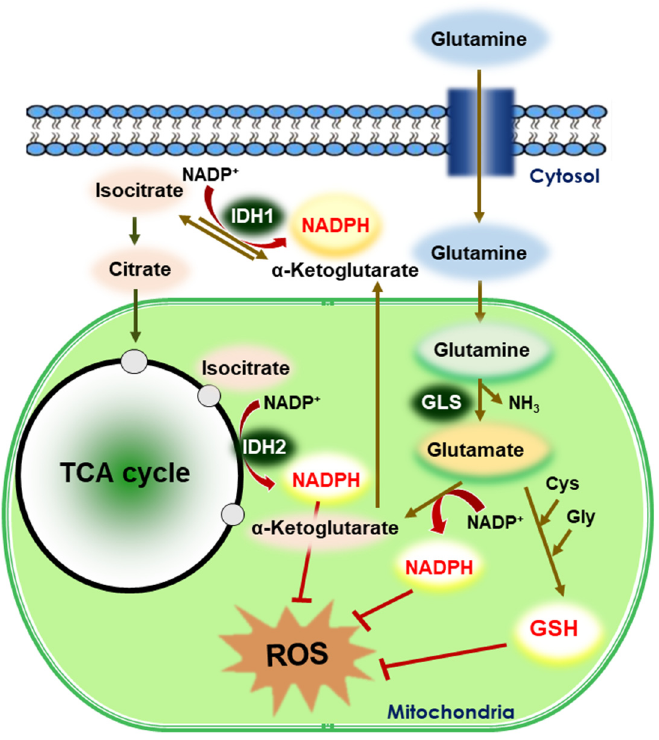
Figure 5. Reductive stress in glutaminolysis. Glutaminolysis is a metabolic pathway that involves the deamination of glutamine by GLS, yielding glutamate and ammonia. Glutamate is then converted to α -ketoglutarate, a TCA cycle intermediate. Glutamine supports the production of GSH and NADPH, which are two major reducing powers in the cells. IDHs catalyze the oxidative decarboxylation of isocitrate to α -ketoglutarate and reduce NADP + to NADPH. In general, IDH1 is predominantly present in the cytosol and IDH2 is localized in the mitochondria. The generated GSH and NADPH mitigate intracellular ROS production.